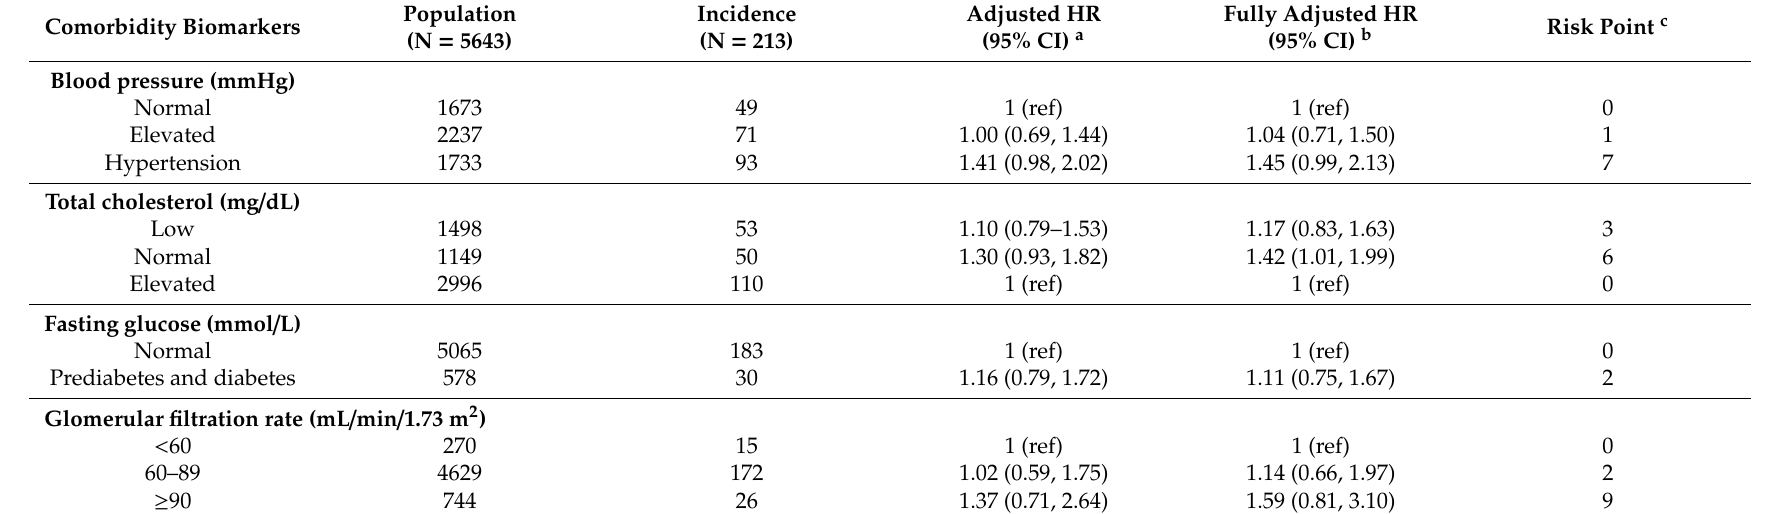
Table A5. Comorbidity biomarkers and the risk of cancer incidence in subjects regardless of time to cancer